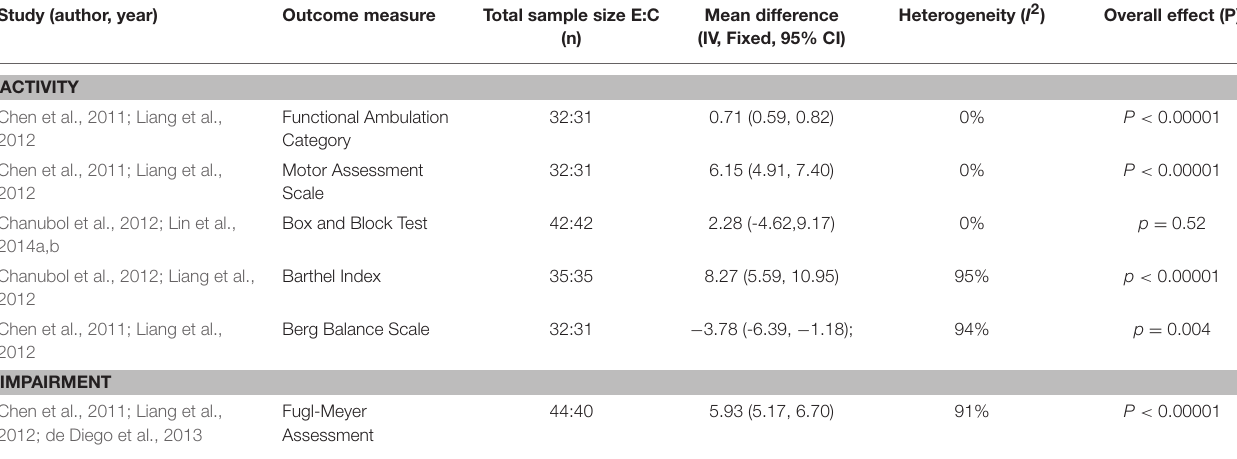
TABLE 2 | Effect size (95% CIs) for sensory training compared to usual care.